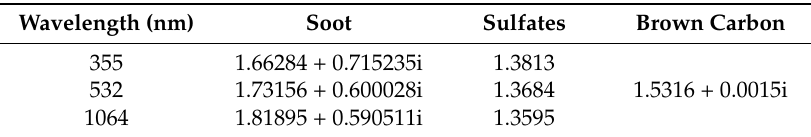
Table 1. Spectral refractive indices used in this